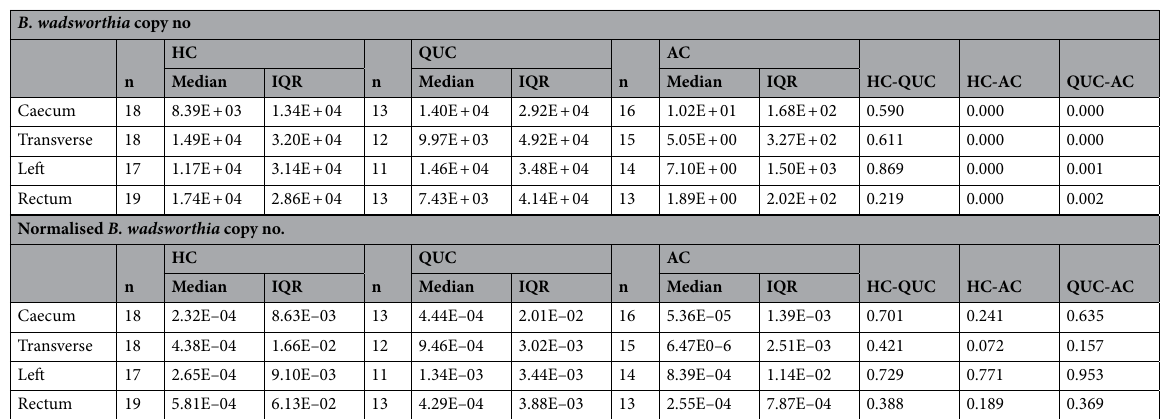
Table 6. Comparison of B. wadsworthia copy number and relative abundance on a loco-regional